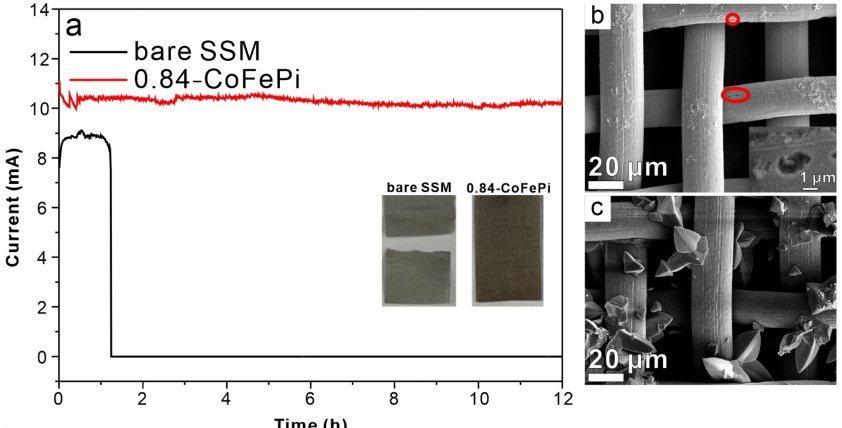
Figure 6. ( a ) Bulk electrolysis of bare SSM and 0.84-CoFePi in 0.0441 wt% H 2 SO 4 solution containing 0.1 M NaCl at the voltage of 2.164 V vs. RHE for 12 h; SEM images of ( b ) bare SSM after the bulk electrolysis, and ( c ) 0.84-CoFePi after the bulk